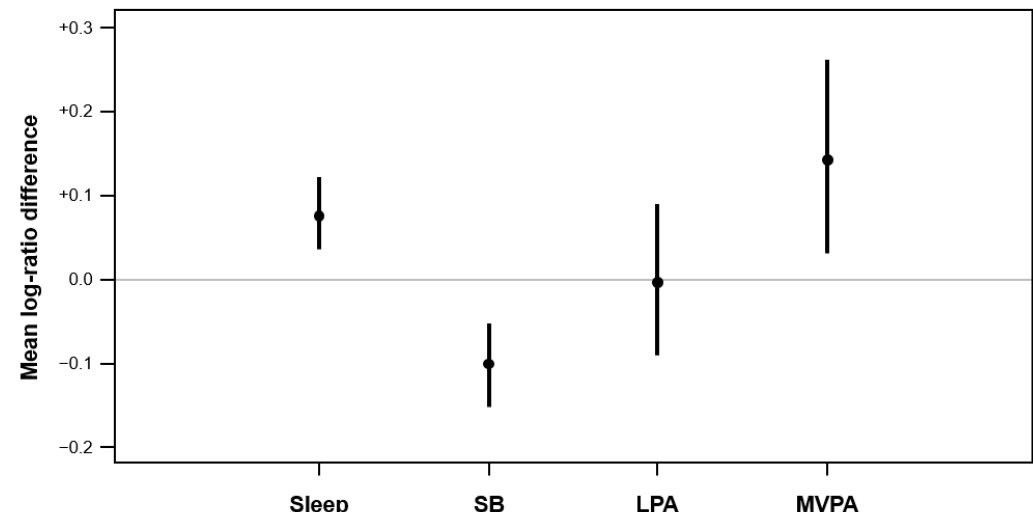
Figure 2. Bootstrapped log-ratio differences of compositional means of movement behaviors between T1 and T2. The log- ratio difference was calculated by using the compositional means of behavior at T2 as the numerator and the compositional means at T1 as the denominator (T2/T1). A positive value of the log-ratio difference (i.e., above zero) indicates that children spent more time in that behavior at T2 than T1. The change within each movement behavior component is considered significant if its 95% bootstrap confidence interval does not cross the zero line. SB = sedentary behavior; LPA = light physical activity; MVPA = moderate-to-vigorous physical activity.